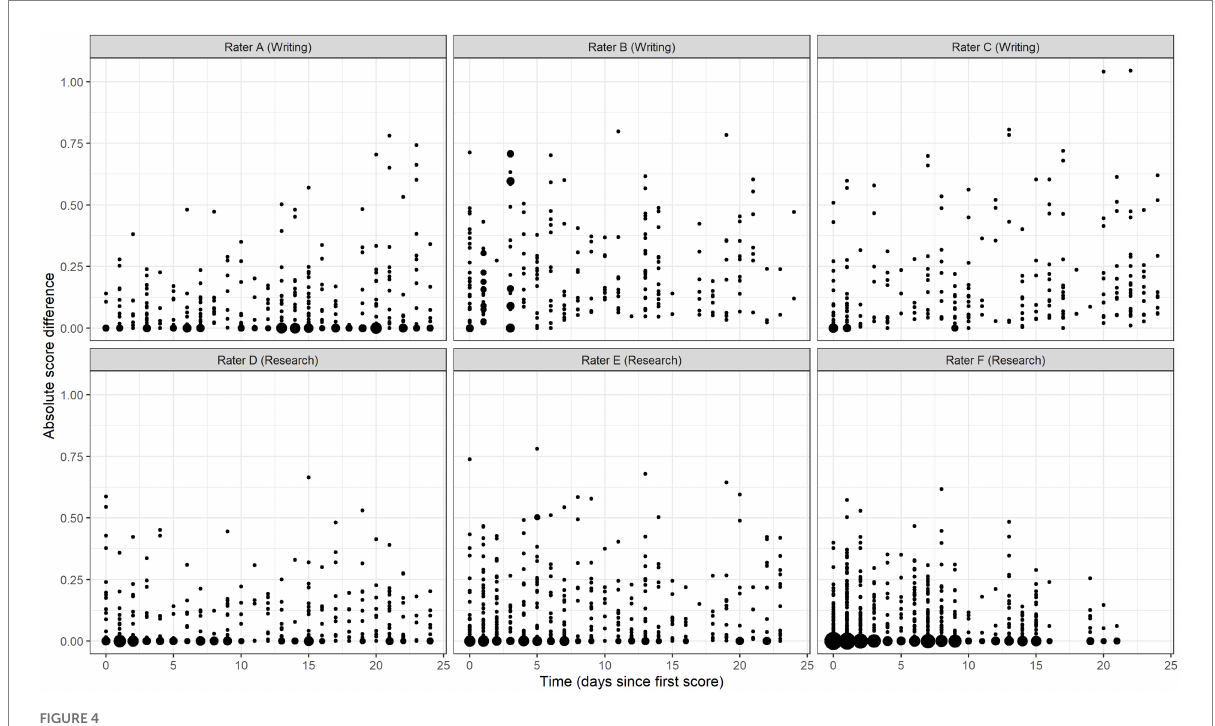
FIGURE 4 Predicted absolute score differences over time for six random